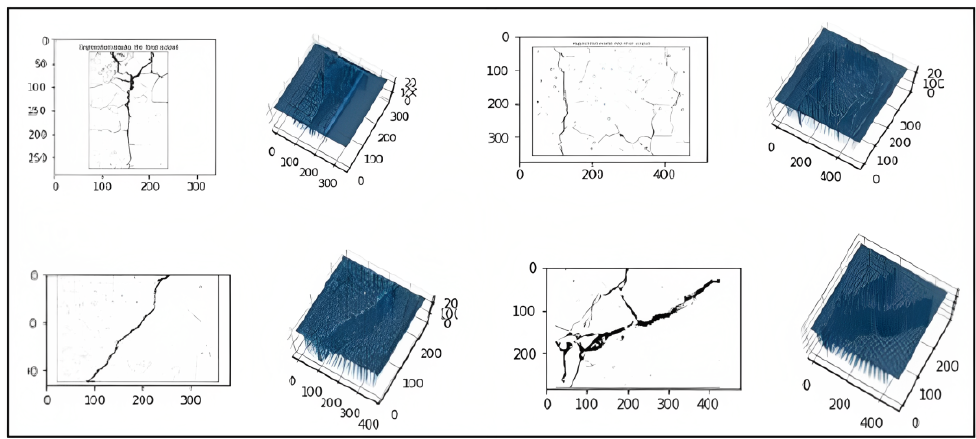
Figure 4. 3D reconstruction of diverse types of cracks.